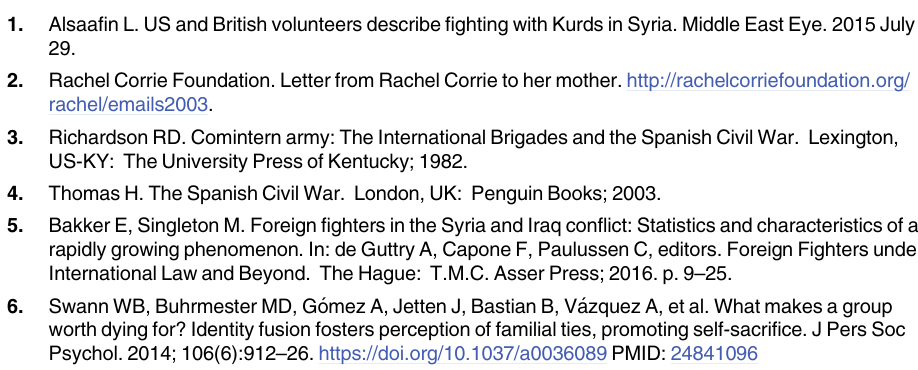
S3 Fig. Moderated mediation model for Study 2, in which knowledge about the conflict is controlled for. Non-significant paths are displayed in grey. (cid:3) p < .05, (cid:3)(cid:3) p < .01, (cid:3)(cid:3)(cid:3) p (cid:20)